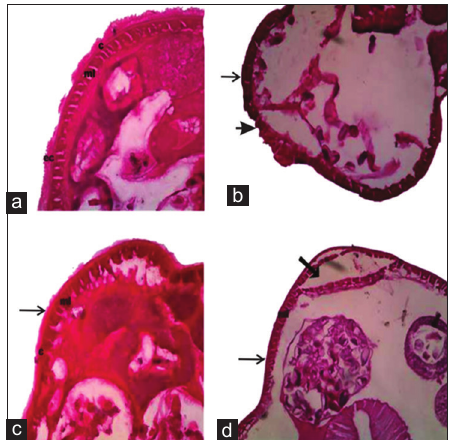
Figure-1: Photomicrograph of sections of Ascaridia galli adult worms (H and E, 10×). (a) Phosphate buffered saline: Appearance of epicuticle, cuticle, and muscle layer, (b) albendazole 15 mg/ml: Depletion epicuticle along with cuticle (thin arrow), damaged cuticle and muscle layer arrowhead), (c) ethanolic extract of Veitchia merrillii betel nuts 25 mg/ml: Depletion epicuticle along with cuticle (thin arrow), (d) ethanolic extract of betel nuts V. merrillii 75 mg/ml: Depletion epicuticle along with cuticle (thin arrow) and irregular shaped cuticle with disruption (thick arrow). ec=Epicuticle, c=Cuticle, ml=Muscle